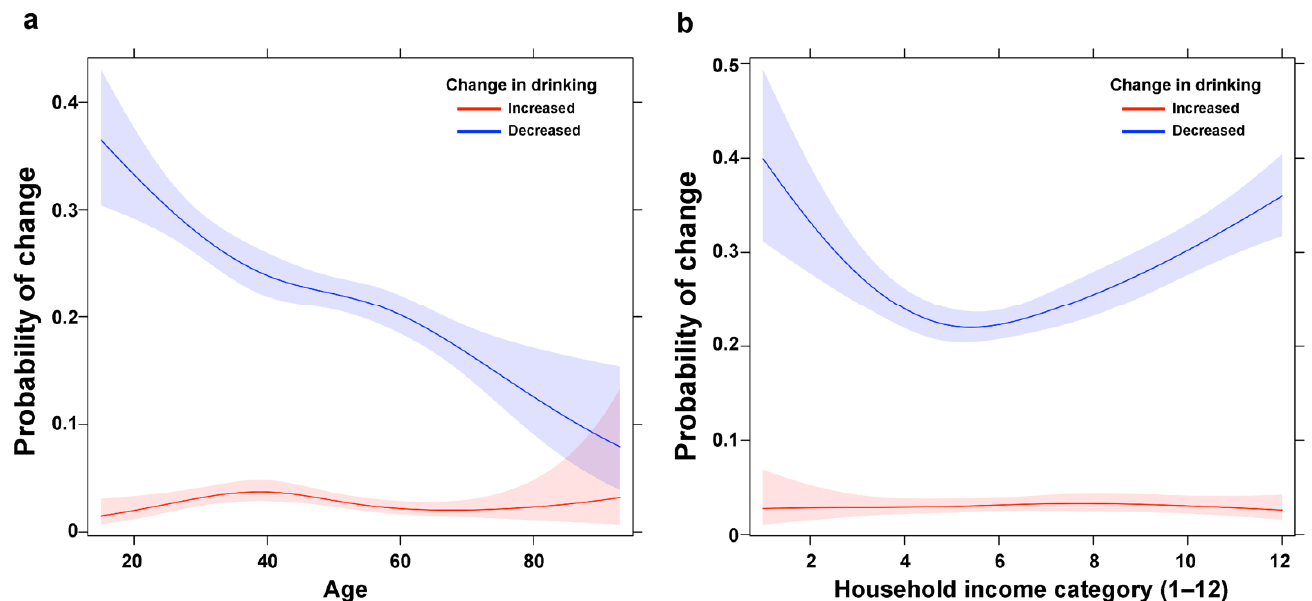
Figure 3. Probability of changes in drinking by ( a ) age and ( b ) household income in restricted cubic spline function. The probability of decreasing the drinking amount during the COVID-19 pandemic was higher for those with younger age, and low and high household income (i.e., a U-shape rela- tionship).